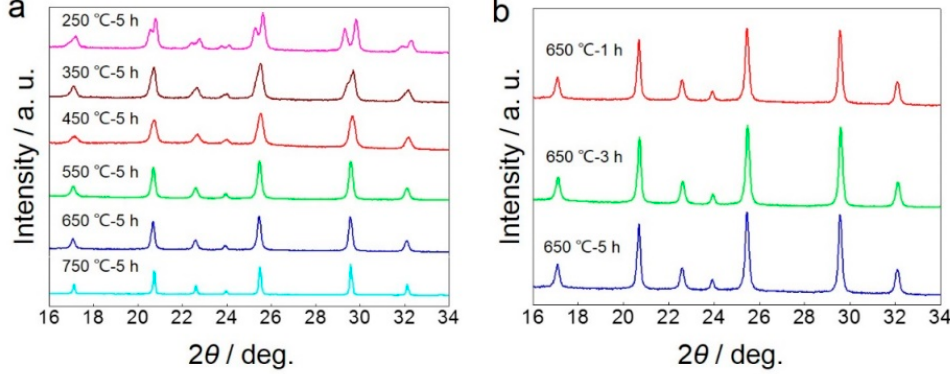
Figure 8. XRD patterns of LiMn 0.4 Fe 0.6 PO 4 samples synthesized without sucrose ( a ) at various calcination temperature; ( b ) for various time at 650 °C.